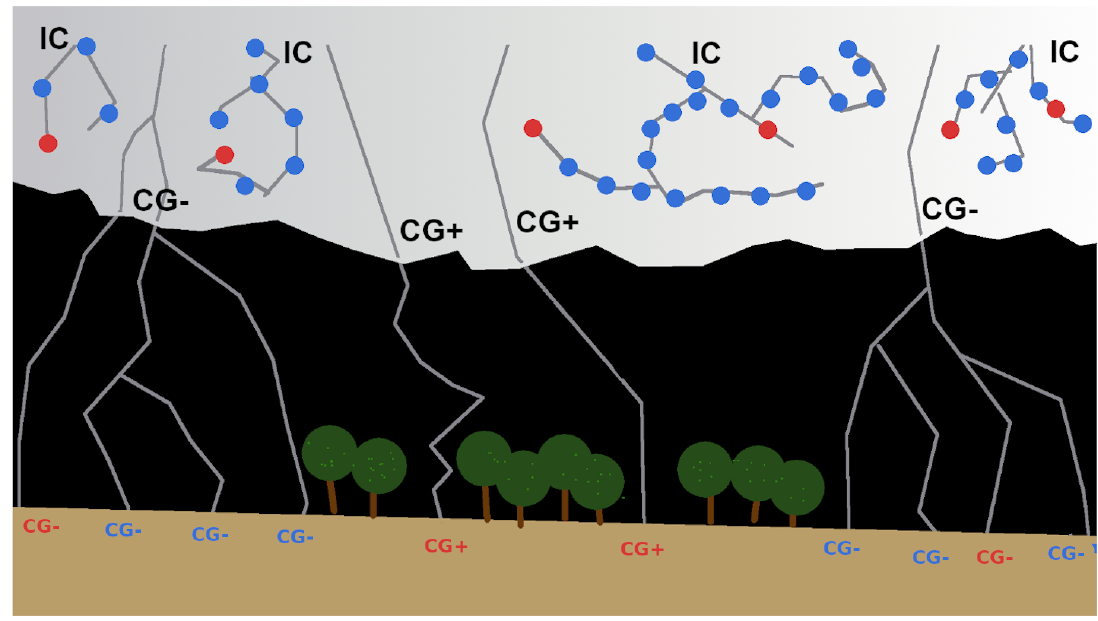
Figure 2. Scheme of the different types of lightning (IC: intra-cloud, CG+: positive cloud-to-ground, CG-: negative cloud-to-ground) in a thunderstorm and the sources (blue ones correspond to Level 1—multiple TL sources—and red ones to Level 2—single flash sources) detected for each one (based on